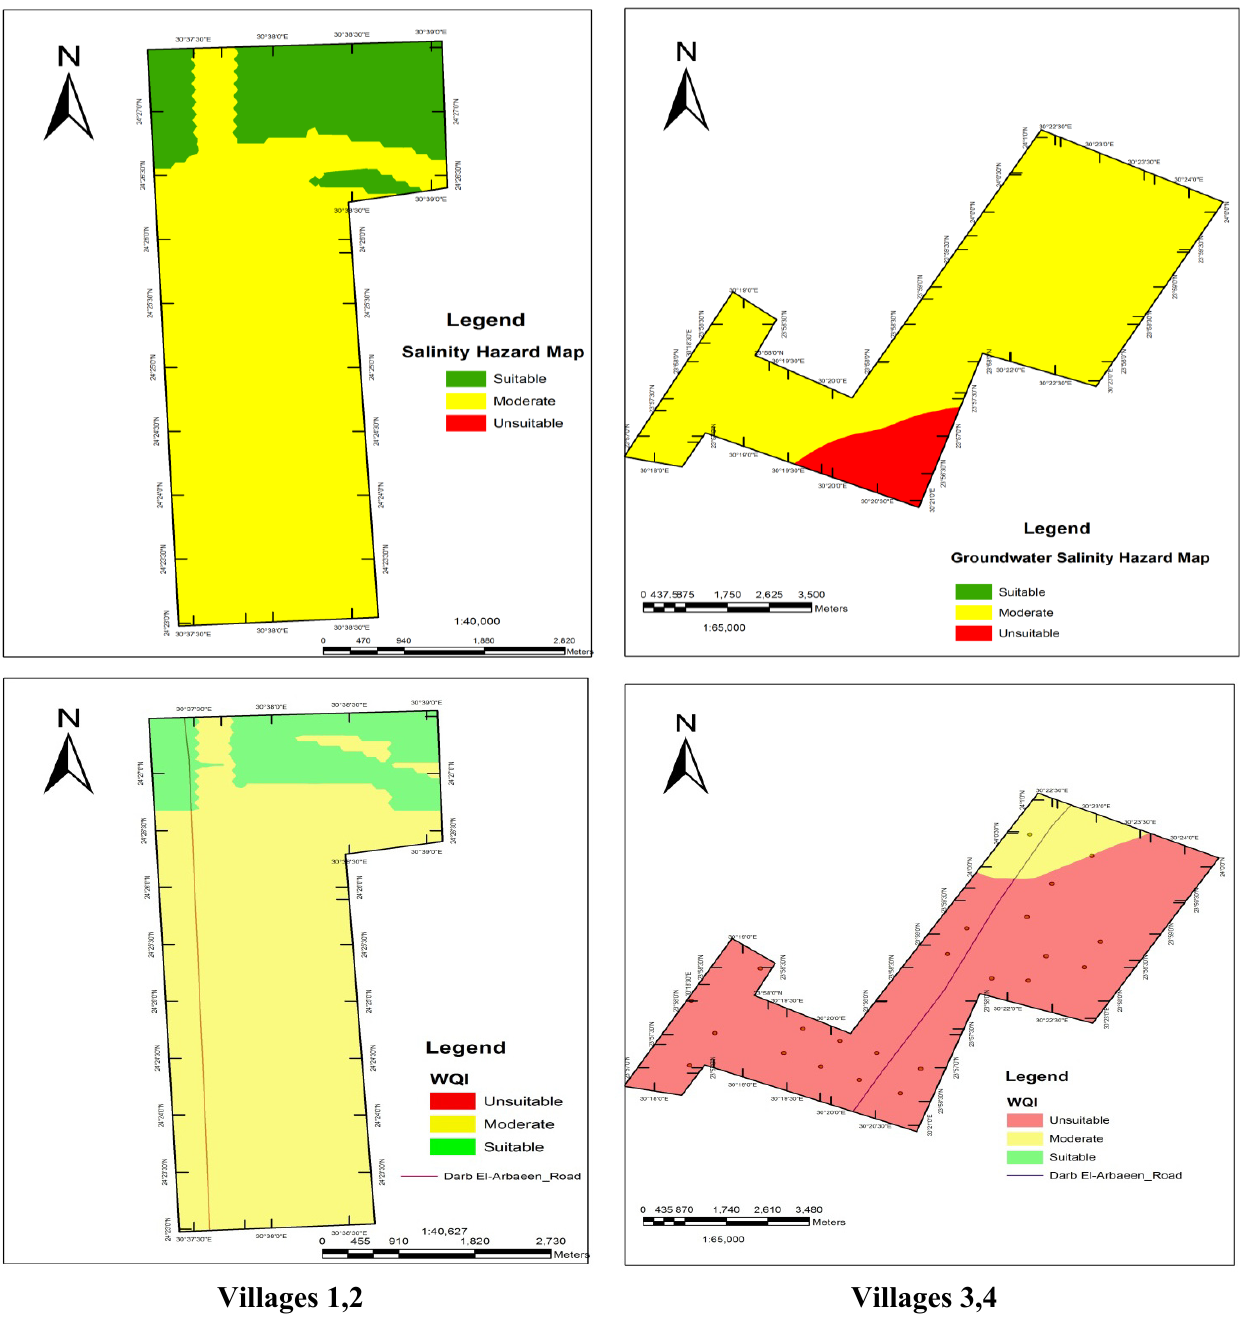
Figure 5. Groundwater salinity hazard map and WQI map of Darb